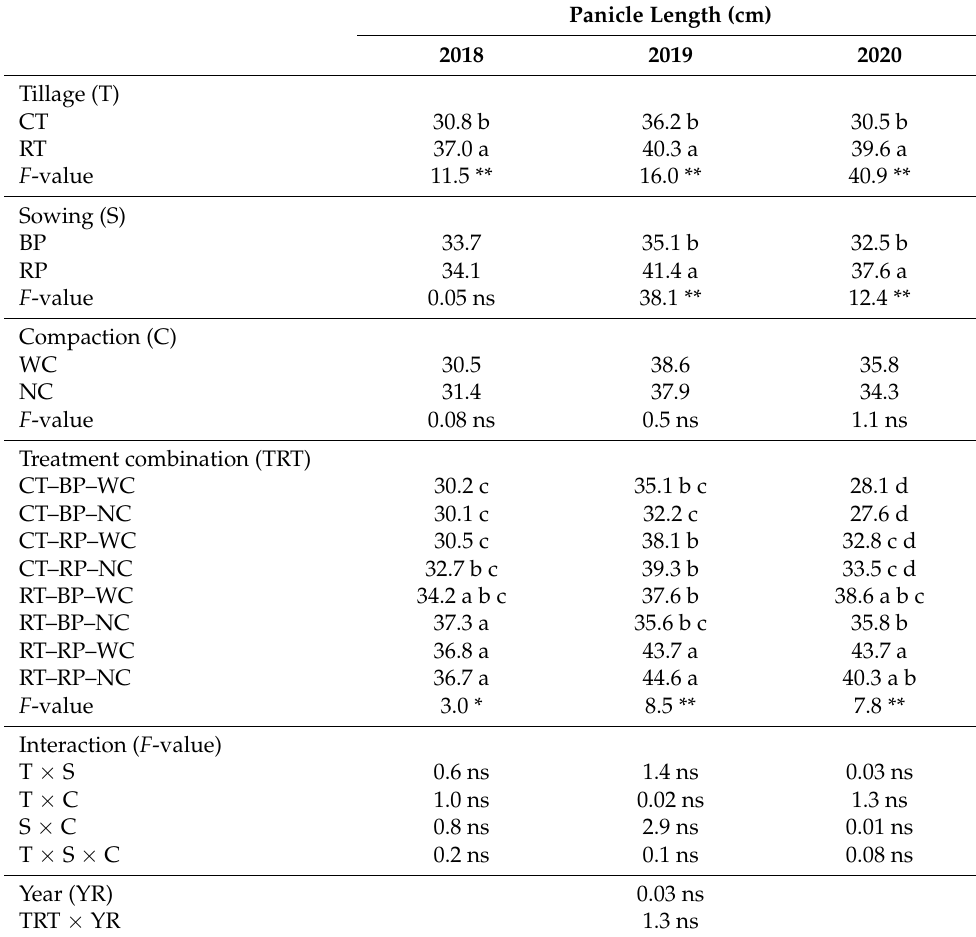
Table 2. Effects of tillage, sowing, and soil compaction methods on panicle length of teff in 2018,